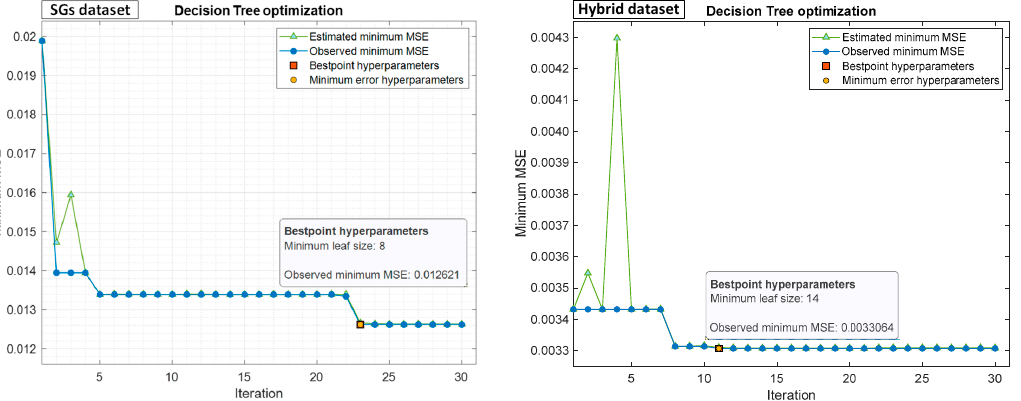
Figure 13. Minimum MSE plots for decision tree method in both experimental and hybrid datasets, which were updated by Bayesian optimization runs.